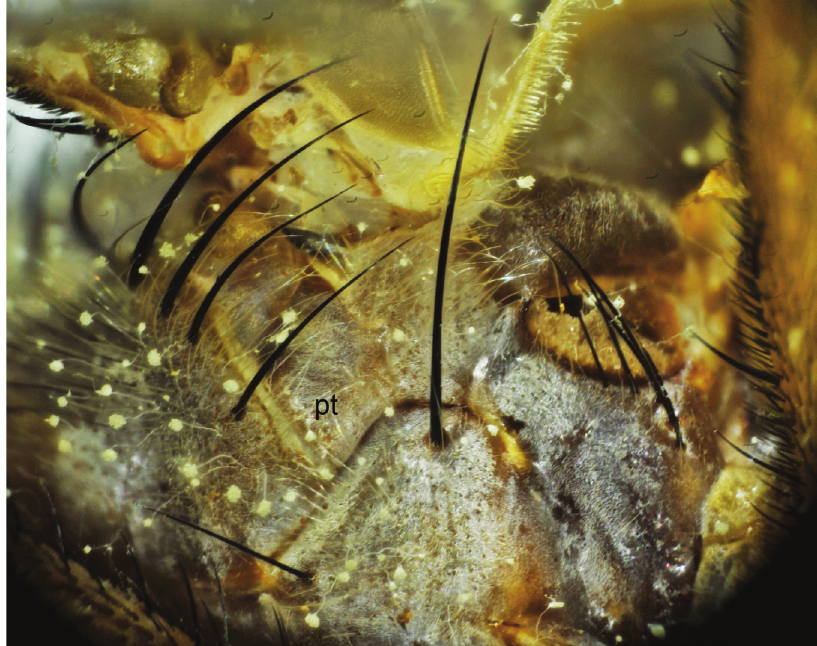
Figure 2. Pteropleuron (pt) of Bengalia chekiangensis Fan, hairs on pteropleuron are totally whitish